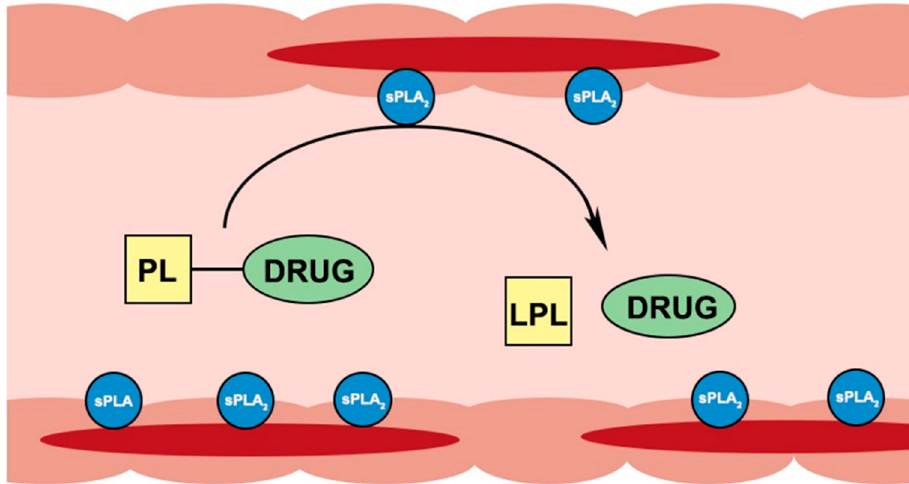
Figure 3. Illustration of PL-drug conjugates activation in the sPLA 2 overexpressing inflamed intestinal tissues of IBD patients.